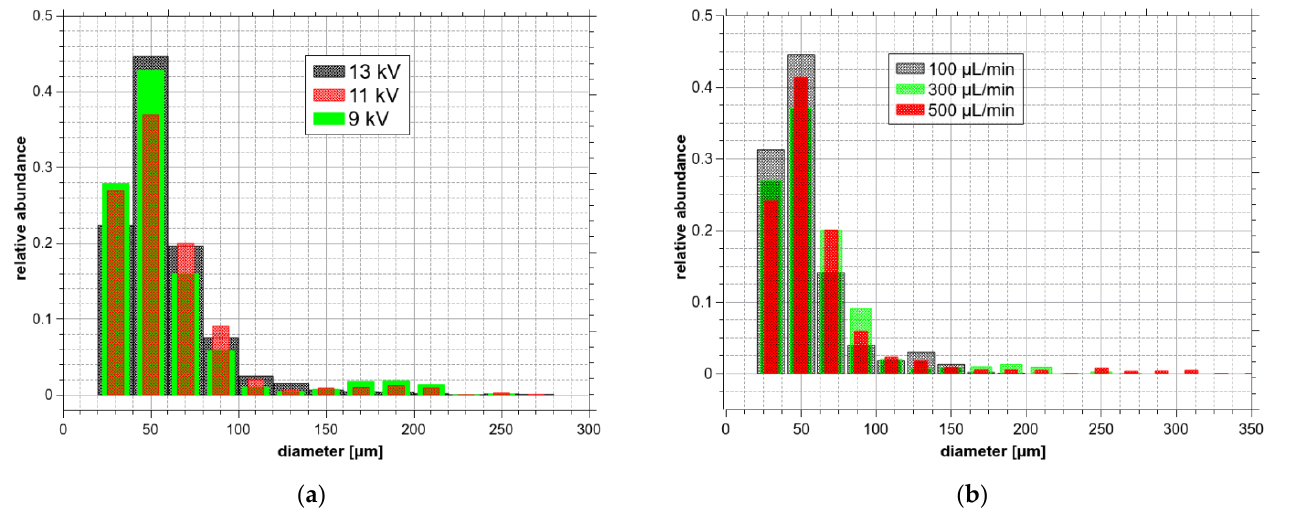
Figure 5. The relative abundance of water microdroplets produced by ES as a function of microdroplets diameter at different V a (kV) and Q w ( µ L/min): ( a ) 9, 11, 13 kV, and 300 µ L/min; ( b ) 11 kV and 100, 300, 500 µ L/min. Microdroplets with a diameter under 20 µ m are below the detection limit of the used camera imaging technique.